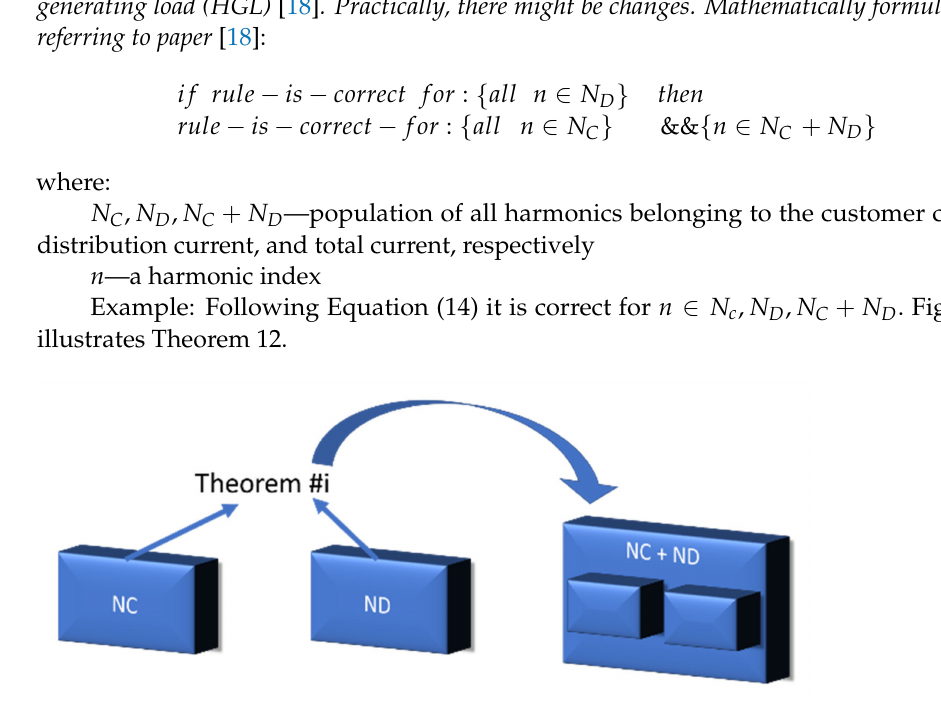
Figure 10. Schematics of Theorem 12: the theorem that is correct for N D (distribution current) is correct for N c (customer current) and N D + N c (total